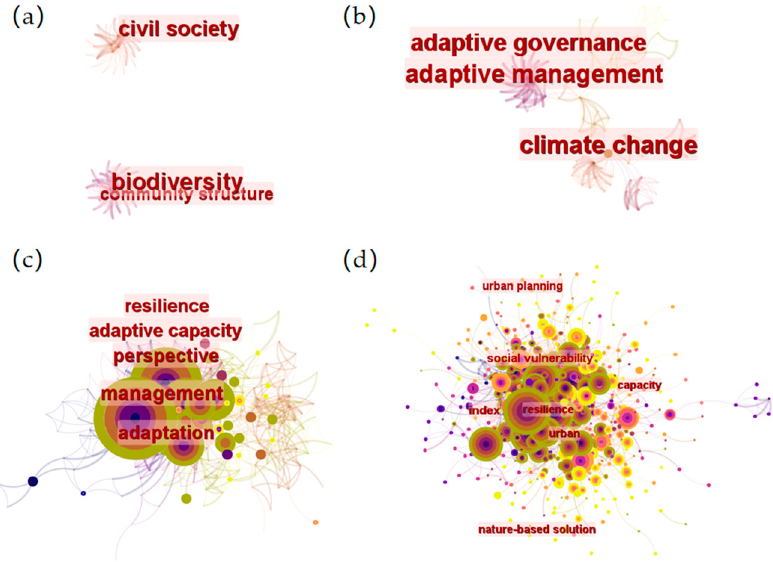
Figure 3. ( a ) Keyword analysis from 1999 to 2005; ( b ) from 2006 to 2010; ( c ) from 2011 to 2015; and ( d ) from 2016 to 2021.